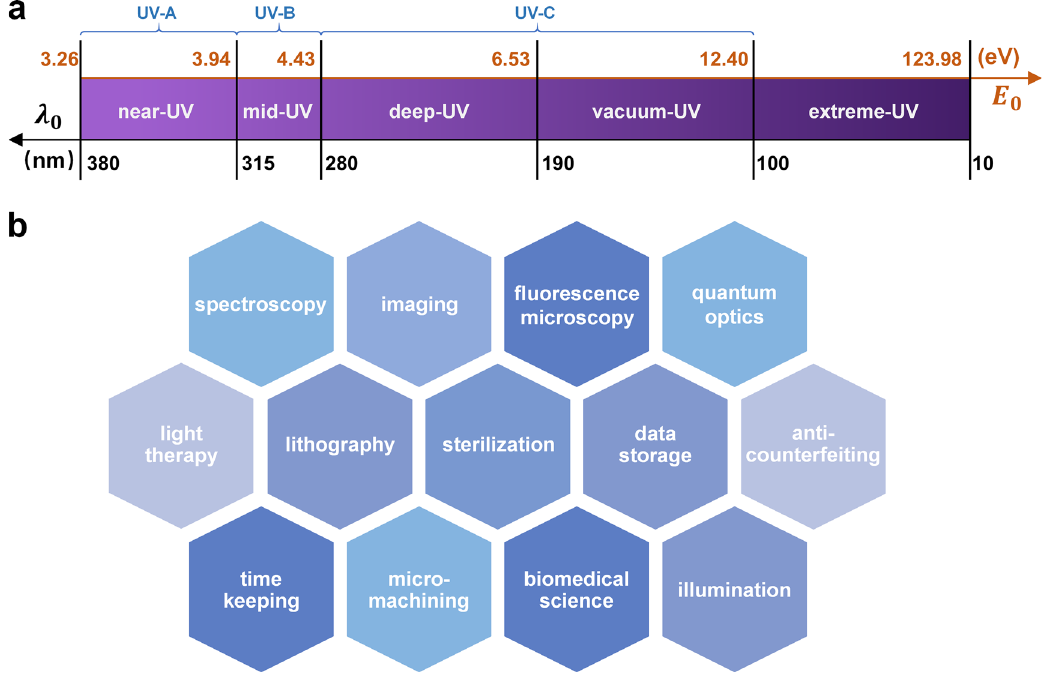
Figure 1: (a) Electromagnetic spectrum for the UV range and the constituent five sub-bands. (b) Representative applications of UV